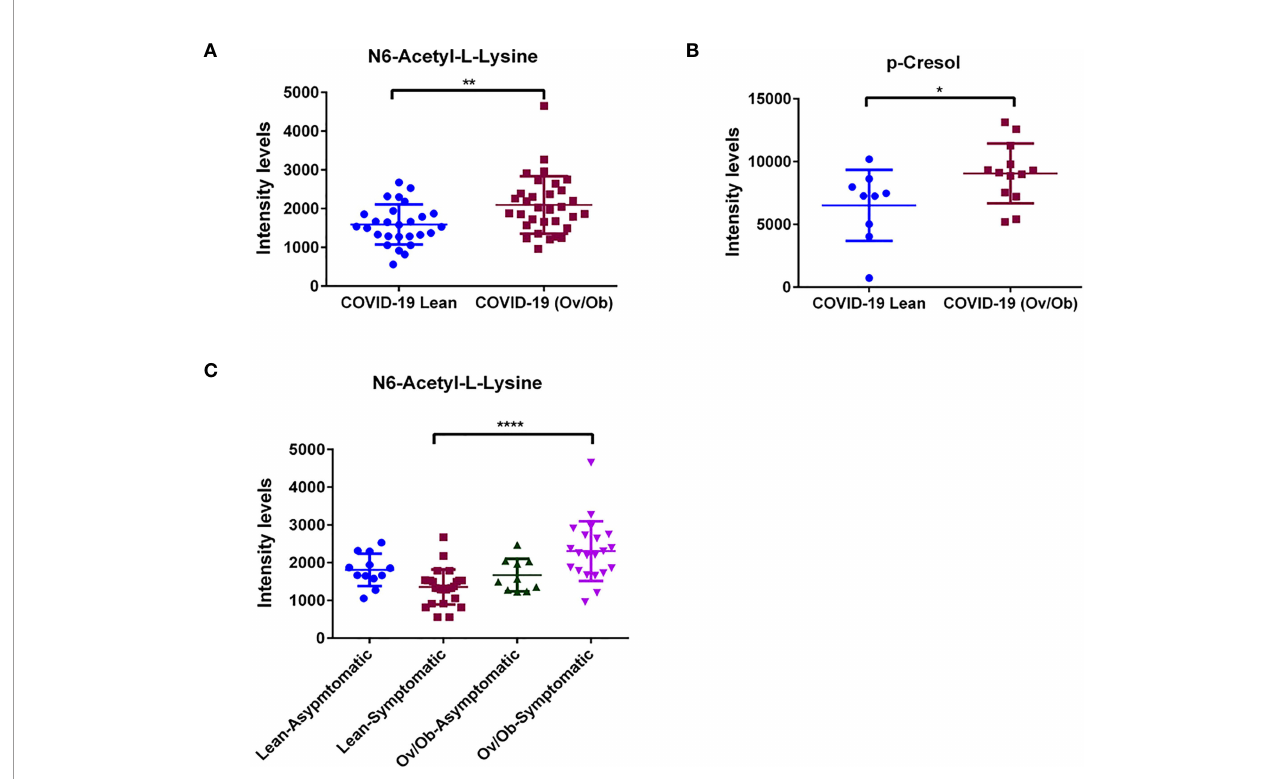
FIGURE 3 | Upregulated levels of plasma metabolites as markers of viral function and adverse complications in COVID-19 obese patients. Plasma levels of (A) N6-Acetyl-L-Lysine were signi fi cantly upregulated when comparing COVID-19 obese and overweight patients to COVID-19 lean patients. Similarly, signi fi cant increase in plasma levels of (B) p-Cresol in COVID-19 overweight-obese patients. Analysis was performed using Mann Whitney t -test with or without Welch ’ s correction test. (C) Plasma metabolite levels of N6-acetyl-l-lysine displayed altered levels that correlated with the occurrence of symptoms in COVID-19 overweight-obese patients. Analysis was performed using one-way ANOVA followed by Dunn ’ s multiple comparison and Kruskal-Wallis test post hoc ; * P < 0.05; ** P < 0.01; **** P <